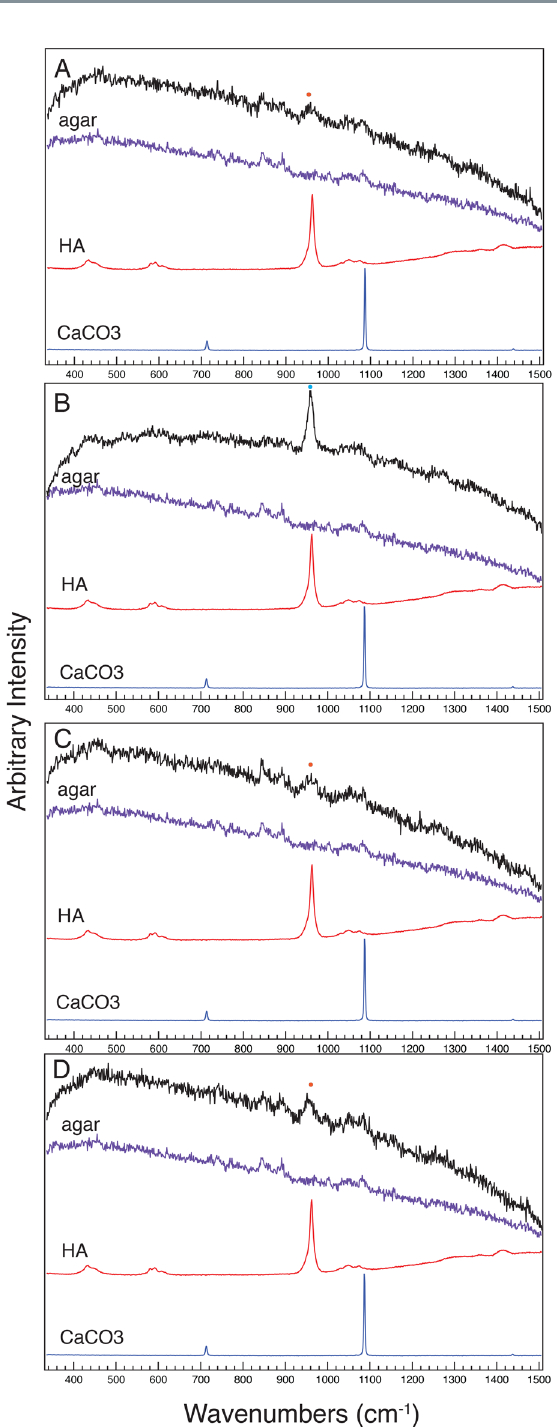
Figure 4. Raman spectra taken from the agar directly adjacent to live colonies of ( A ) P. putida KT2440, ( B ) P. syringae pv. morsprunorum 5795, ( C ) P. syringae pv. tomato DC3000, and ( D ) P. fluorescens Pf0-1, at six days of growth are colored black in each panel. A control spectrum for NB agar is labelled “agar” and colored in purple, a control spectrum for hydroxyapatite is labelled “HA” and colored in red, and a control spectrum for calcium carbonate is labelled “CaCO 3 ” and is colored in blue. A broad peak centered around 955 cm − 1 is labelled with an orange dot in the spectra for P. putida KT2440, P. syringae pv. morsprunorum 5795, and P. fluorescens Pf0-1 and reflects the presence of amorphous calcium phosphate in these samples. A sharper peak centered at 959 cm − 1 in P . syringae pv. tomato DC3000 is labelled with a light blue dot and reflects the presence of amorphous apatite. The assay was repeated three independent times and the spectra are representative of those assays. The y-axis is in arbitrary intensity units and the x-axis is in wavenumbers (cm − 1